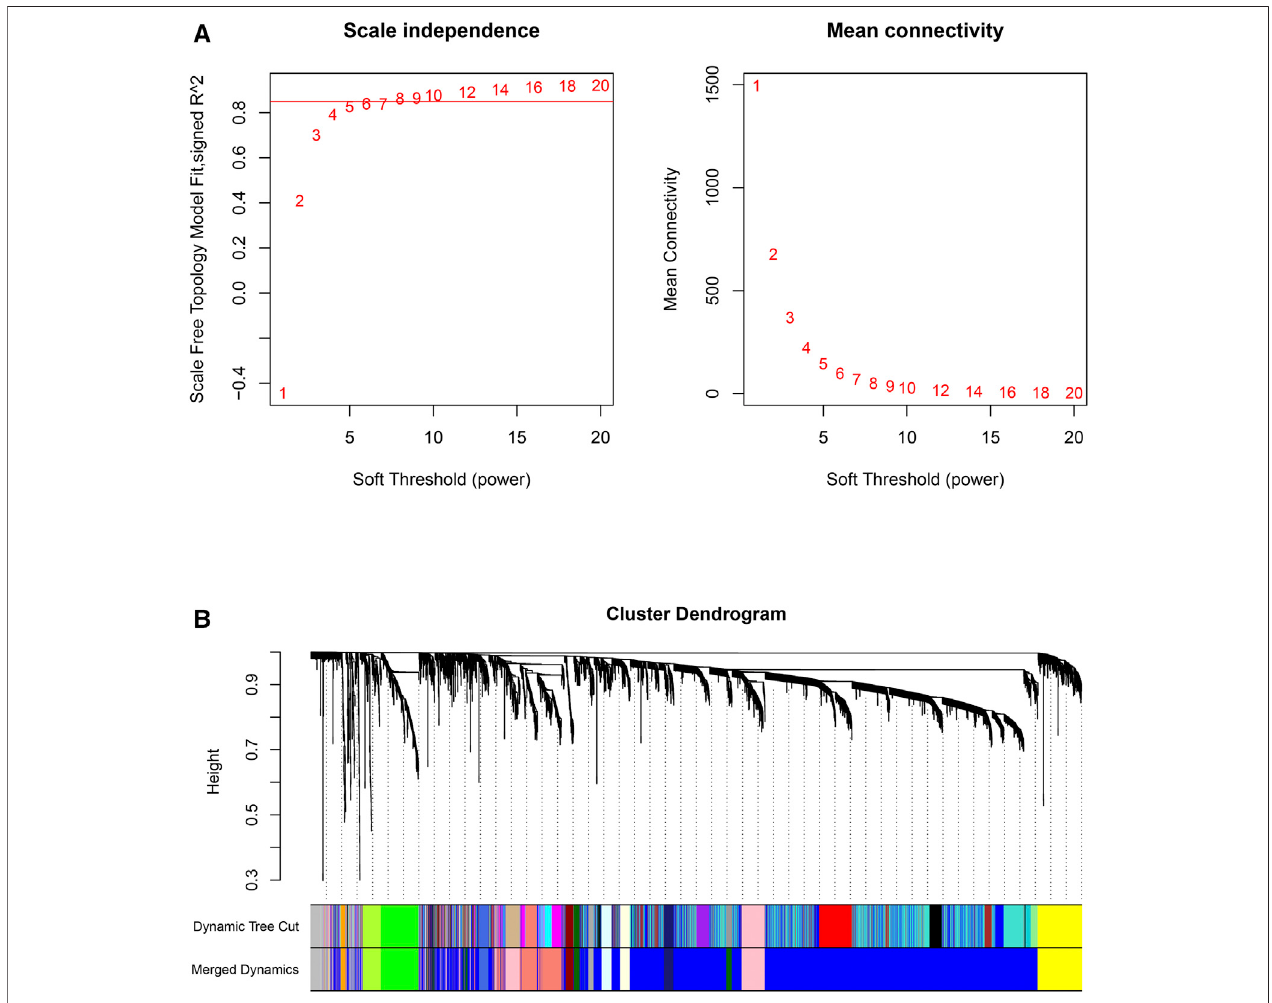
FIGURE 2 | Scale-free networks were constructed, and genes were clustered by WGCNA. (A) : Scale-free network analysis under different soft-thresholding powers. The left panel shows scale-free topological indices at different soft-thresholding powers. The right panel shows the correlation analysis between the soft- thresholding powers and average connectivity of the network. (B) : Gene clustering diagram based on hierarchical clustering under optimal soft-thresholding power. (Dynamic Tree Cut: before module merging; Merged Dynamics: after module merging).